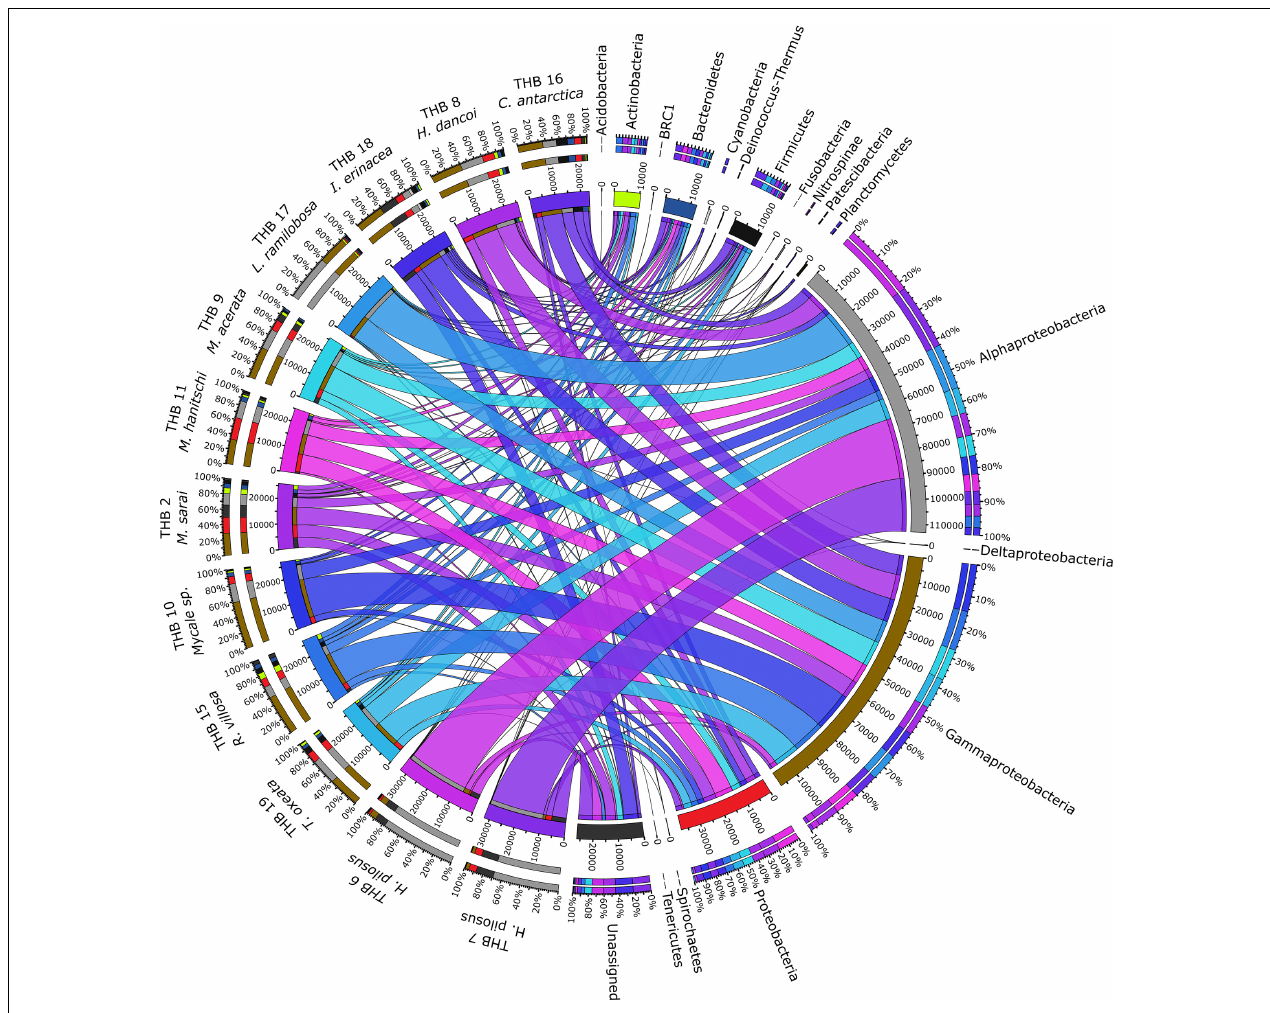
FIGURE 2 | The figure shows the connection among main phyla found in association with the different analyzed sponges. The sponges analyzed are shown on the right of the image, with the color scale from blue to purple (the colors of the ribbons inside the figure). Main phyla found in different colors are shown on the left (colors from top to bottom: orange, yellow, sea blue, silver, gray, black, light green, dark blue, blue, ash, light gray, teal, brown, red, dark green, light green and dark gray). Ribbon size in the figure codifies cell value associated with Sponge/phyla segment pair. Finally, the histograms present under the different sponge species report the percentage distribution of the different phyla inside the